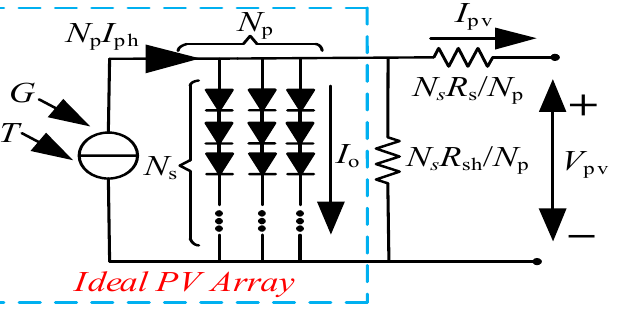
Figure 2. Equivalent circuit of implicit PV array.